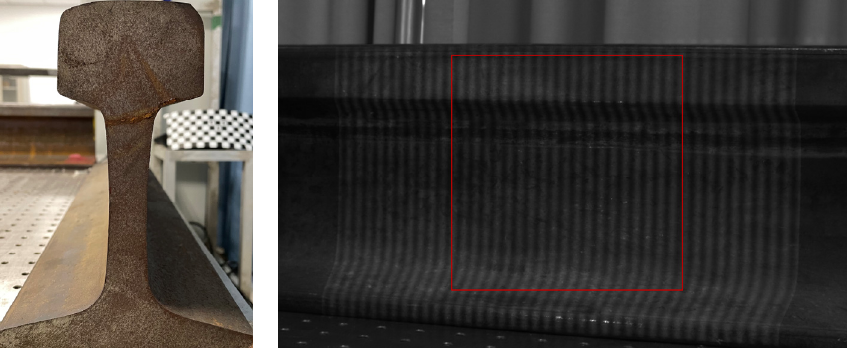
Figure 16. Rail shape and deformed fringe pattern.